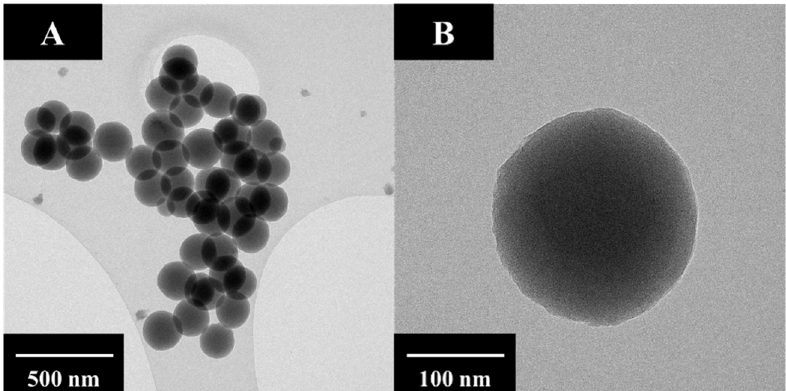
Figure 1. TEM images of PVDF particles at ( A , B ) different magnifications.